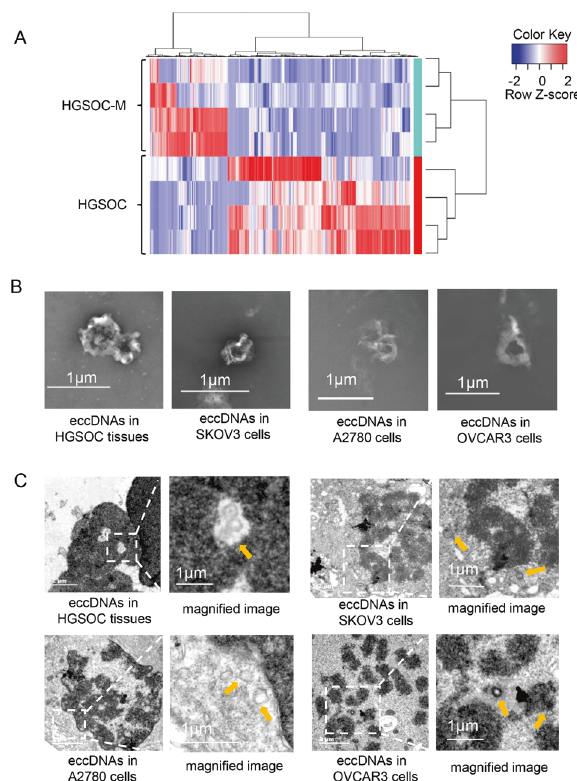
Fig. 3 EccDNAs are differentially expressed in paired primary and metastatic tissues of HGSOC. A Clustered heatmap showing differentially expressed eccDNAs in paired primary tissues and metastatic tissues of four HGSOC patients. Red, up-regulation; Blue, down-regulation. B The SEM images of extracted eccDNAs in HGSOC tissues and ovarian cancer cell lines SKOV3, A2780 and OVCAR3. Scale bar, 1 μ m. C The TEM images of eccDNAs in HGSOC tissues, SKOV3, A2780, and OVCAR3 cells. Scale bars, 2 μ m and 1 μ m. All imaging experiments were repeated at least three times, with similar